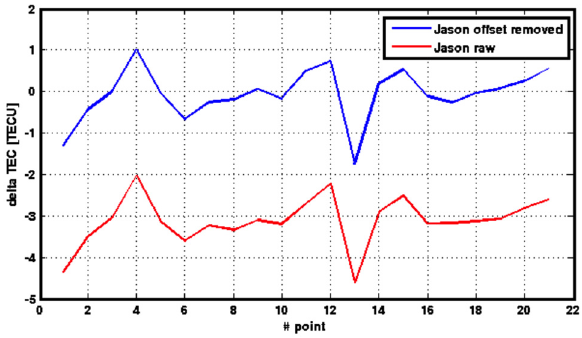
Figure 6. Mean VTEC biases before (red plot) and after (blue plot) removing the estimated